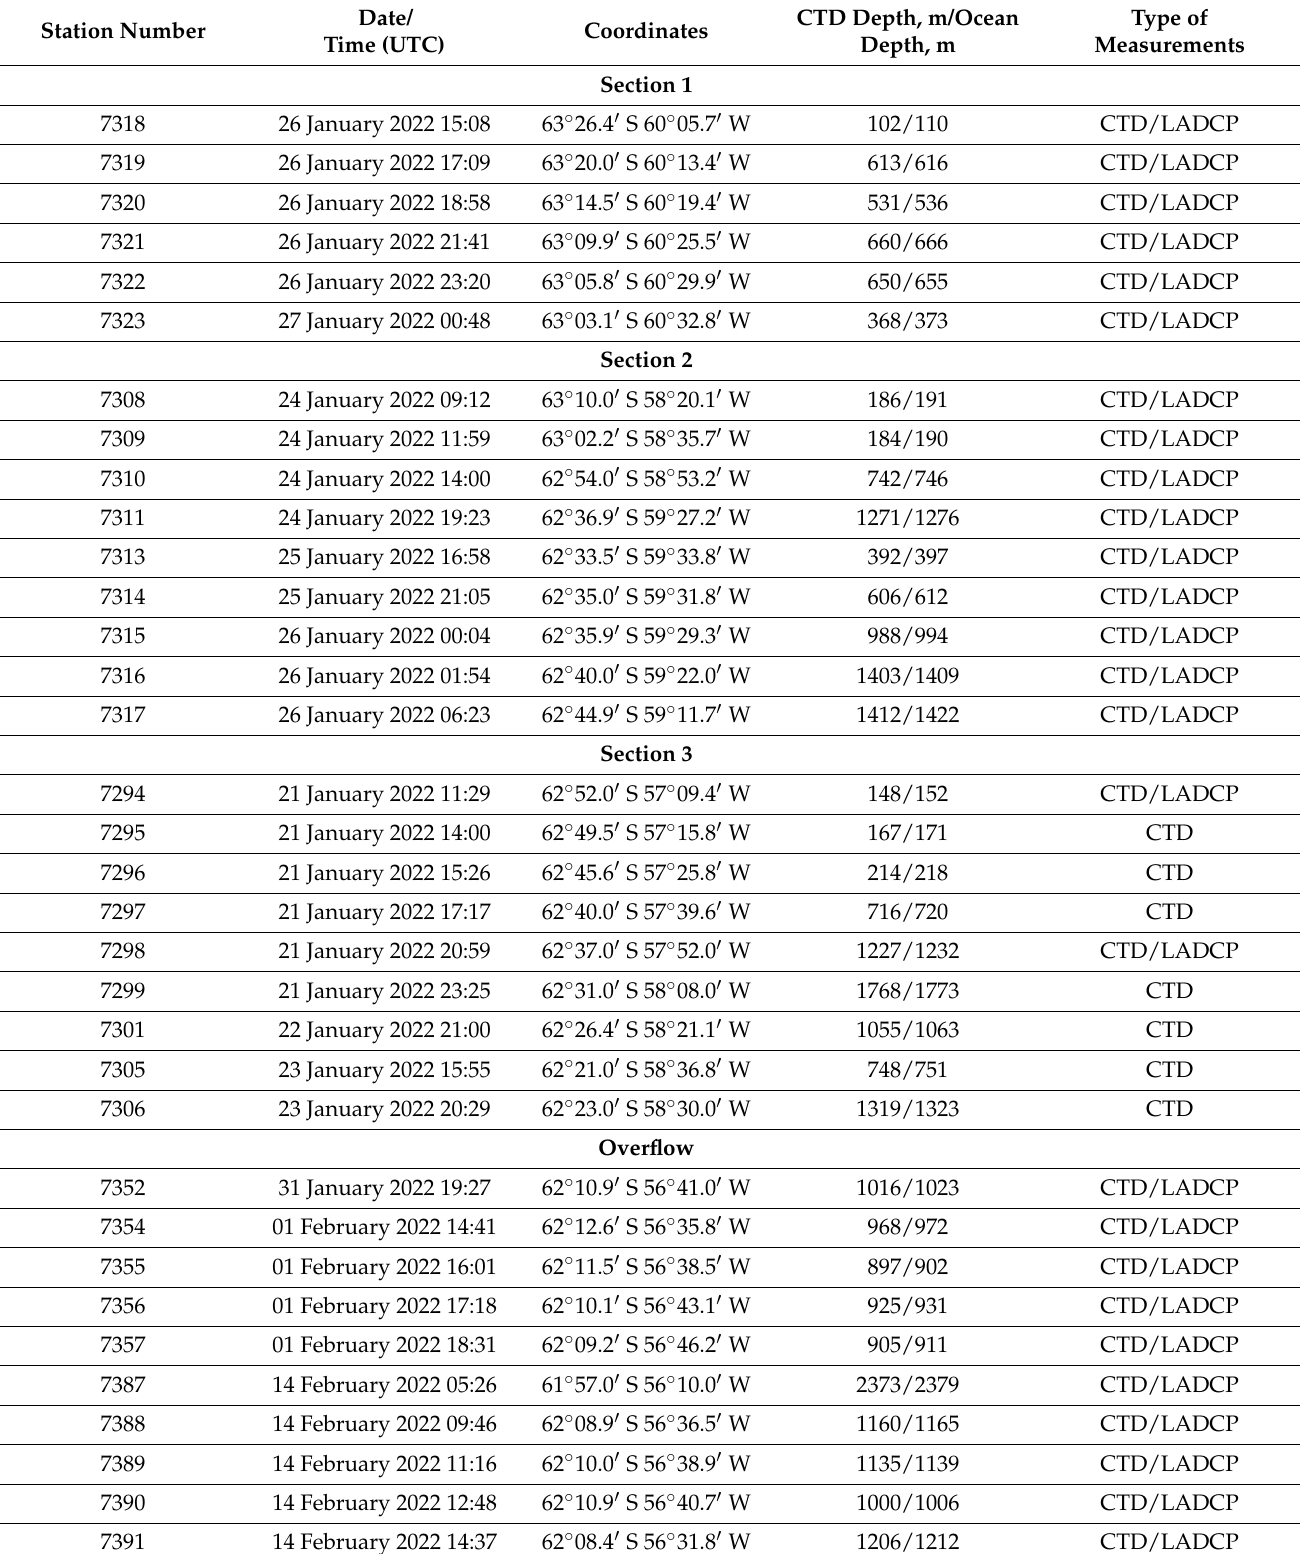
Table 1. Coordinates of stations carried out in the Bransfield Strait in January and February